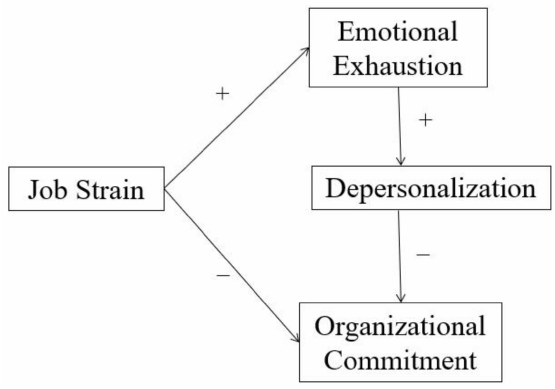
Figure 1. Hypothetical